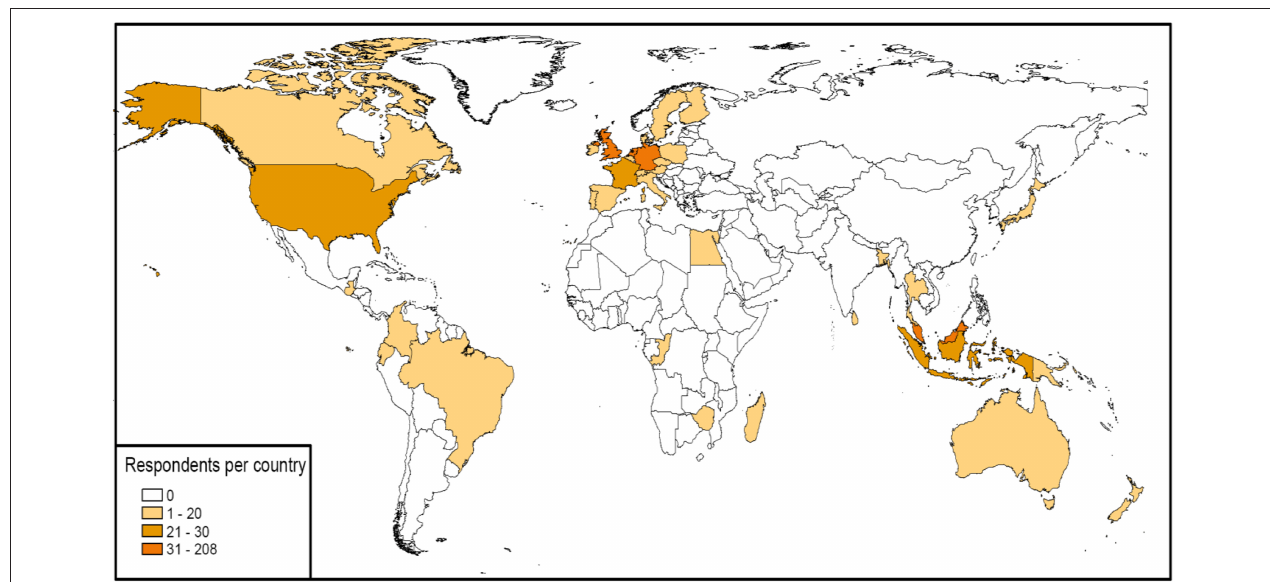
FIGURE 3 | Geographical breakdown of participants involved in the palm oil research consultation